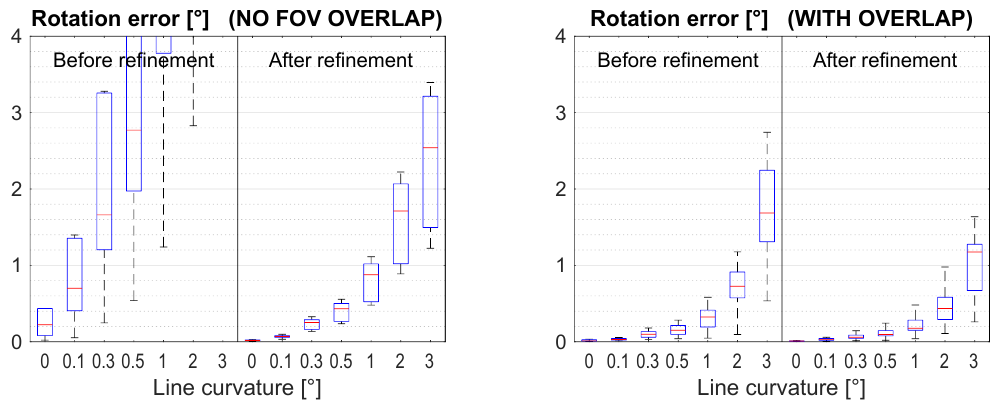
Figure 10. Results when varying the plane curvature for the scene without and with